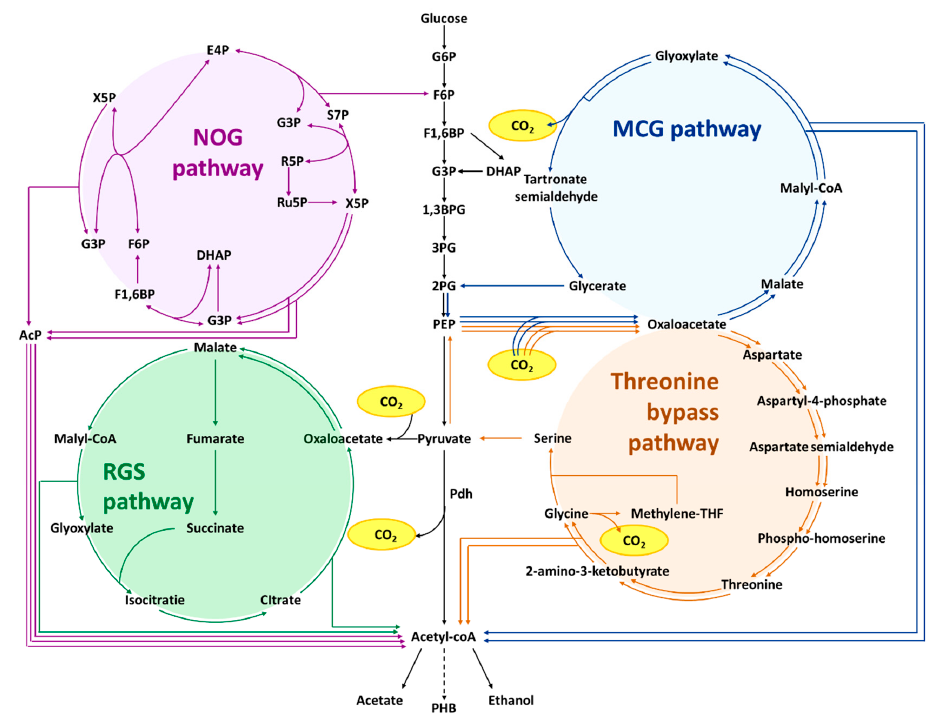
Figure 6. Synthetic Pdh bypass to increase the acetyl-CoA yield from sugar. The purple arrows indicate the non-oxidative glycolysis (NOG) pathway, which converts sugar phosphate to the acetyl-phosphate or further acetyl-CoA in a stoichiometry amount. The green arrows indicate the reverse glyoxylate shunt (rGS), leading to two acetyl-CoA from one pyruvate. The blue arrows indicate the malyl-CoA-glycerate (MCG) pathway, which net converts one phosphoenolpyruvate (PEP) to two acetyl-CoA. The orange arrows indicate the threonine bypass, which is able to convert one PEP into two acetyl-CoA. Redox equivalents and energy requirements of each reaction are not shown in this scheme. Abbreviations: G6P, glucose-6-phosphate; F6P, fructose-6-phosphate; F1,6P, fructose-1,6-bisphosphate; DHAP, dihydroxyacetone phosphate; G3P, glyceraldehyde 3-phosphate; 1,3BPG, 1,3-bisphosphoglycerate; 3PG, 3-phosphoglycerate; 2PG, 2-phosphoglycerate; PEP,